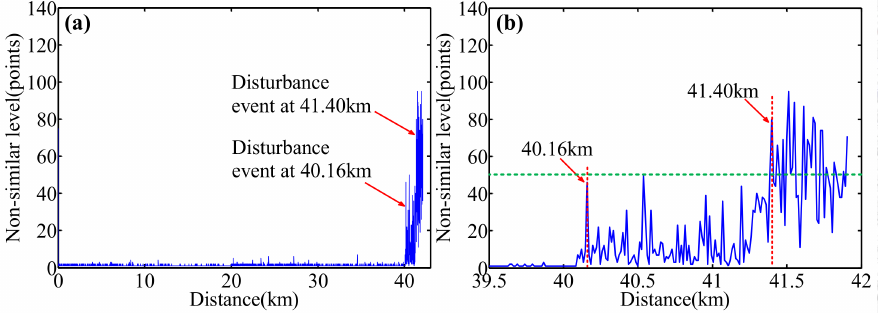
Figure 20. Measured distributed “non-similarity level” as a function of a FUT length with two concurrent vibration events. The PZT 1 at 40.16 km is applied by a triangle wave with 2 V. The PZT 2 at 41.40 km is applied by a triangle wave with ( a ) 2 V, ( b ) 3 V (reprinted from Ding et al. [54] with permission of IEEE; copyright